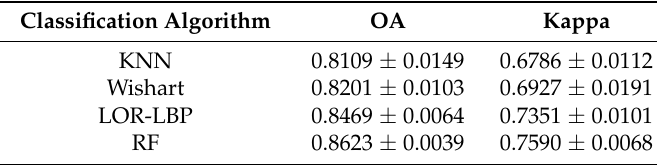
Table 7. Classification results for RadarSat-2 imagery with different classification algorithms. Classification Algorithm